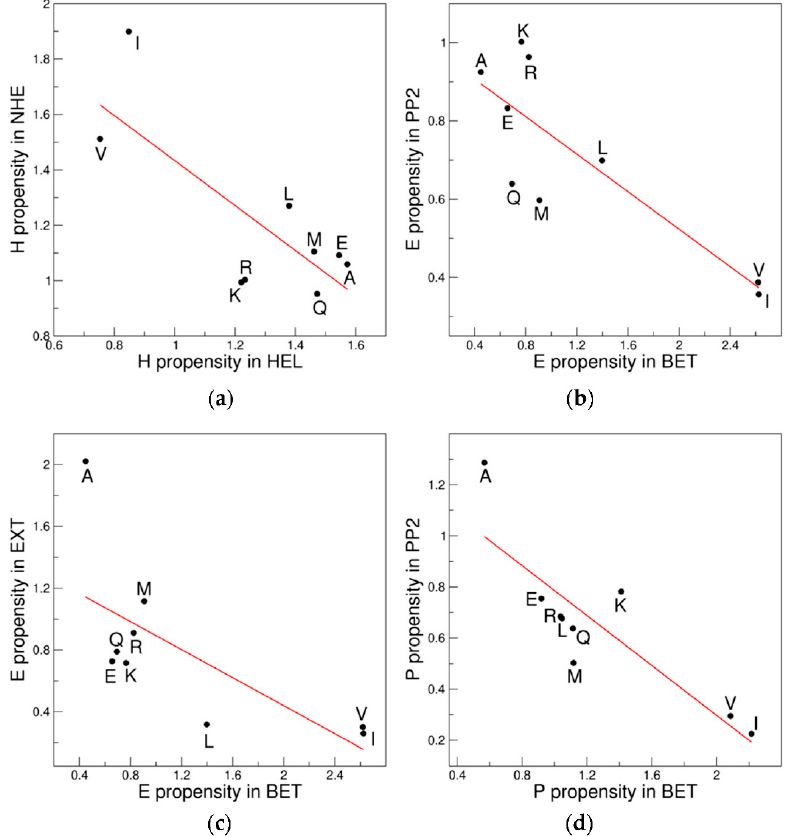
Figure 8. Significant anticorrelations of the propensity scales for the same secondary structure elements in distinct ( φ , ψ ) clusters detected in the 9AA ensemble: ( a ) HEL_H versus NHE_H; ( b ) BET_E versus PP2_E; ( c ) BET_E versus EXT_E; and ( d ) BET_P versus PP2_P. Comparing the propensity scales for the two helical structures (H and G) in the same cluster (HEL), we observe that the significant ‘H versus G’ correlation previously detected (R = 0.87, p = 0.0024) for the 9AA ensemble in the Ramachandran plot is confirmed or it is even more significant in this cluster (R = 0.89, p = 0.0013) (Figure 9). Surprisingly, the propensity scales for the β -sheet and polypropline II structures (E and P), which, as pre- viously shown, anticorrelate (R = − 0.69, p = 0.038—9AA ensemble) if the 9AA residues populating the entire Ramachandran space were considered, are instead strongly corre- lated if calculated in the individual BET (R = 0.92, p = 4.4 × 10 − 4 ) and PP2 (R = 0.81, p = 0.0081) clusters (Figure 9).